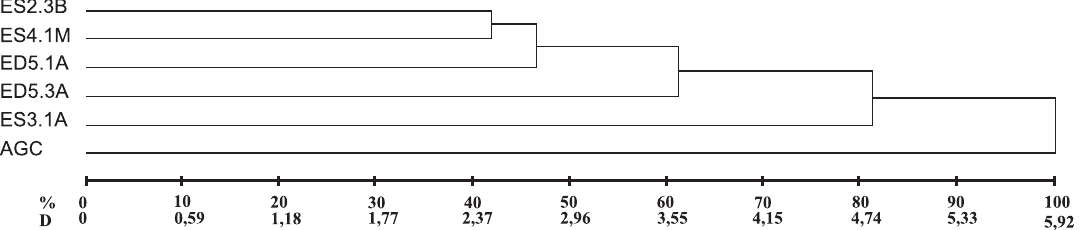
1. Clustering of Rhizoctonia -like fungi based on the averages of fatty acid proportions using the Standardized Euclidean Distance (D) and the UPGMA method. Codes in the clusters correspond to the isolates presented in